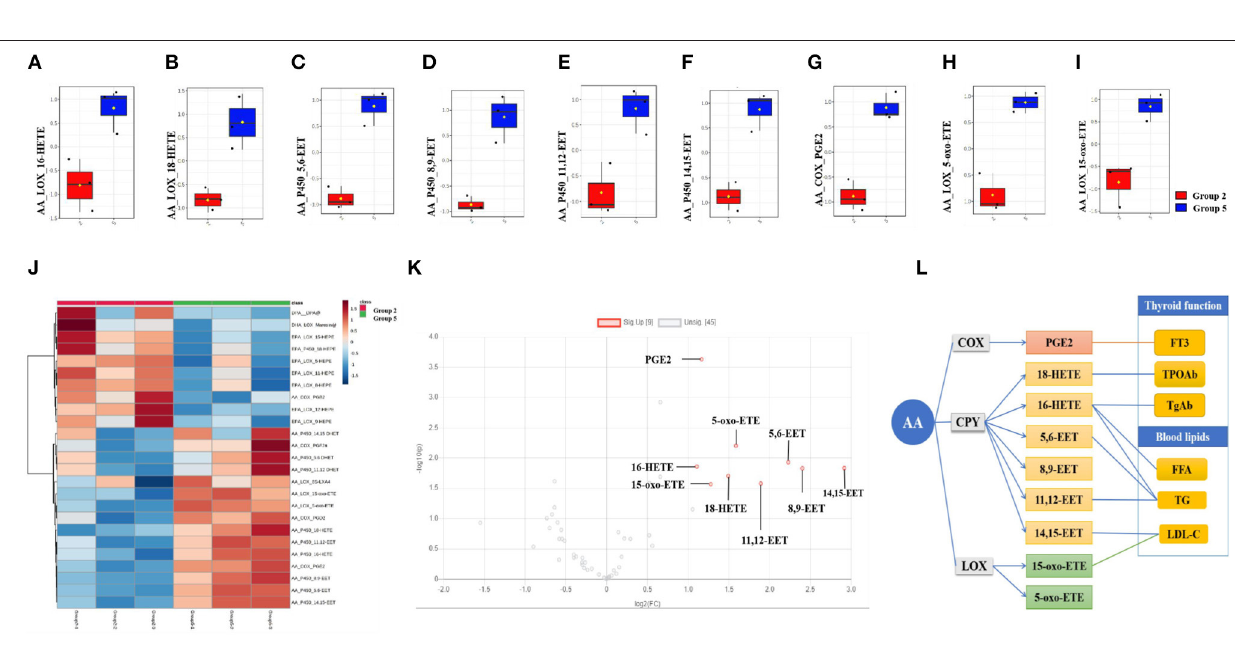
FIGURE 5 | Fatty acids profile and correlation analysis in adjustment from 100 HI to NI administration + 1,25(OH) 2 D 3 supplementation group (group 5). (A–I) Box plots of the fatty acids levels in serum. The bar in the quartile-indicating box is the median value. (J) Heat map from group 5 and group 2. (K) Volcano plot. (L) Correlation analysis. n = 6 for each